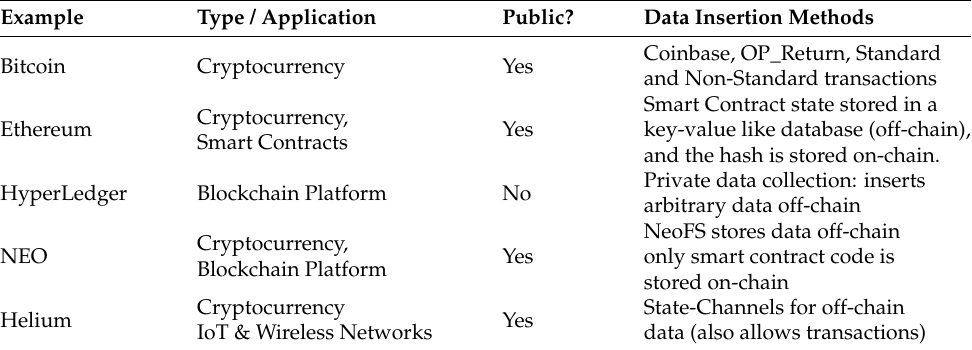
Table 1. Examples of data insertion methods in popular